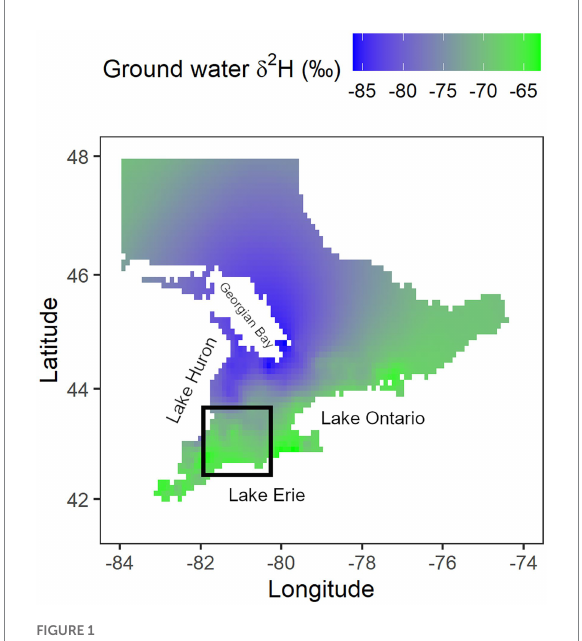
FIGURE 1 Kriged plot of groundwater δ 2 H values (‰) from shallow well data (less than 32 m) for southern Ontario. Data were extracted from the waterisotopes.org database ( n = 703). Black square represents the study